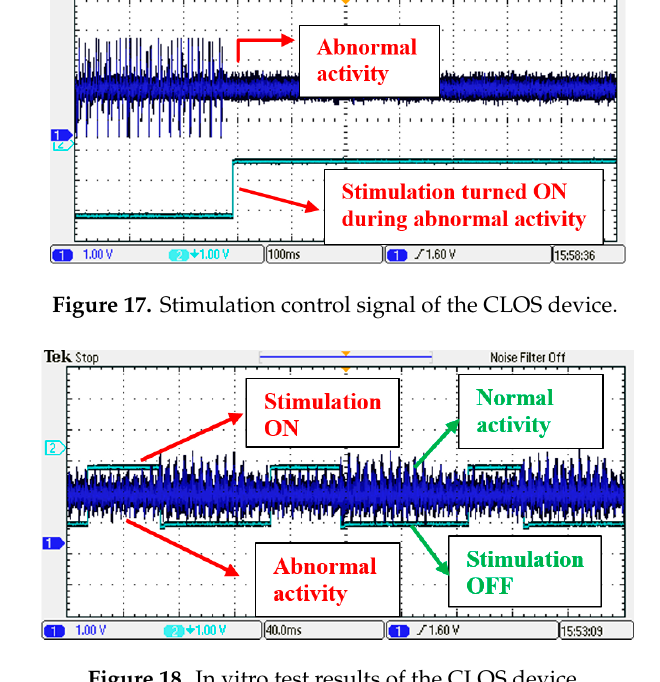
Figure 18. In vitro test results of the CLOS device.